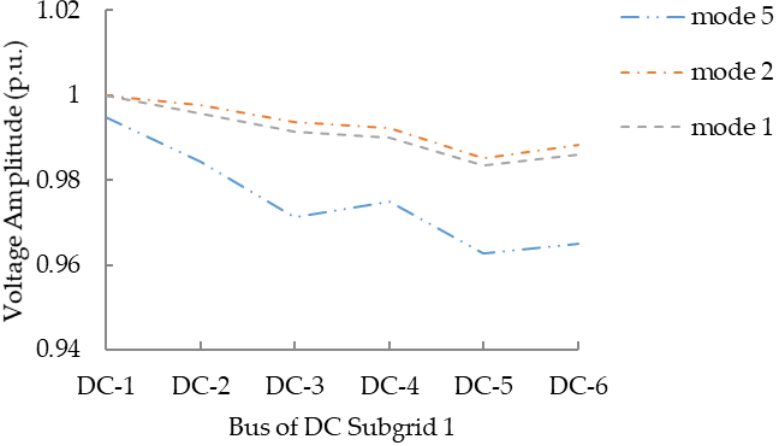
Figure 9. The DC bus voltage profiles of DC subgrid 1.